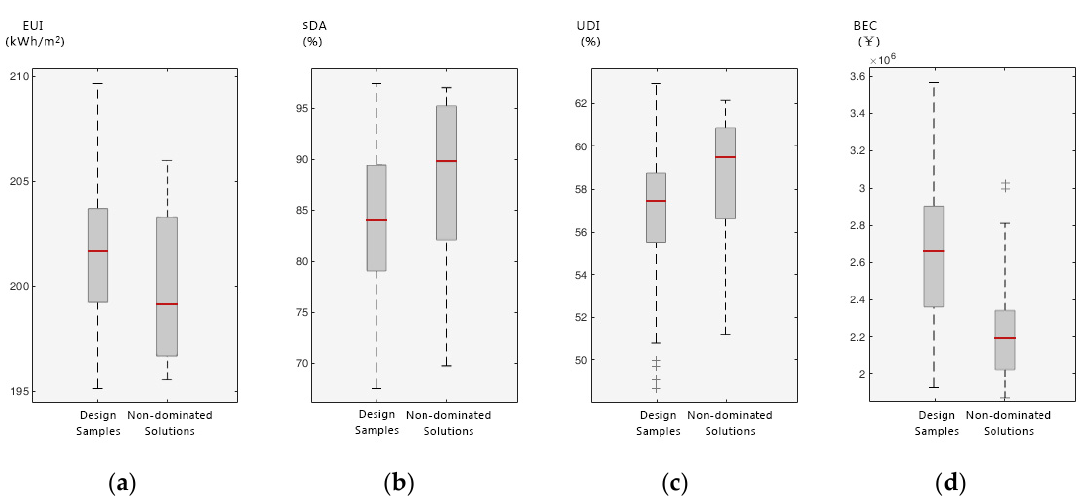
Figure 14. The objective value distribution of design samples and non-dominated solutions: ( a ) Energy Use Intensity (EUI) value distribution; ( b ) Spatial Daylight Autonomy (sDA) value distribution; ( c ) Useful Daylight Illuminance (UDI) value distribution; ( d ) Building Envelope Cost (BEC) value distribution.